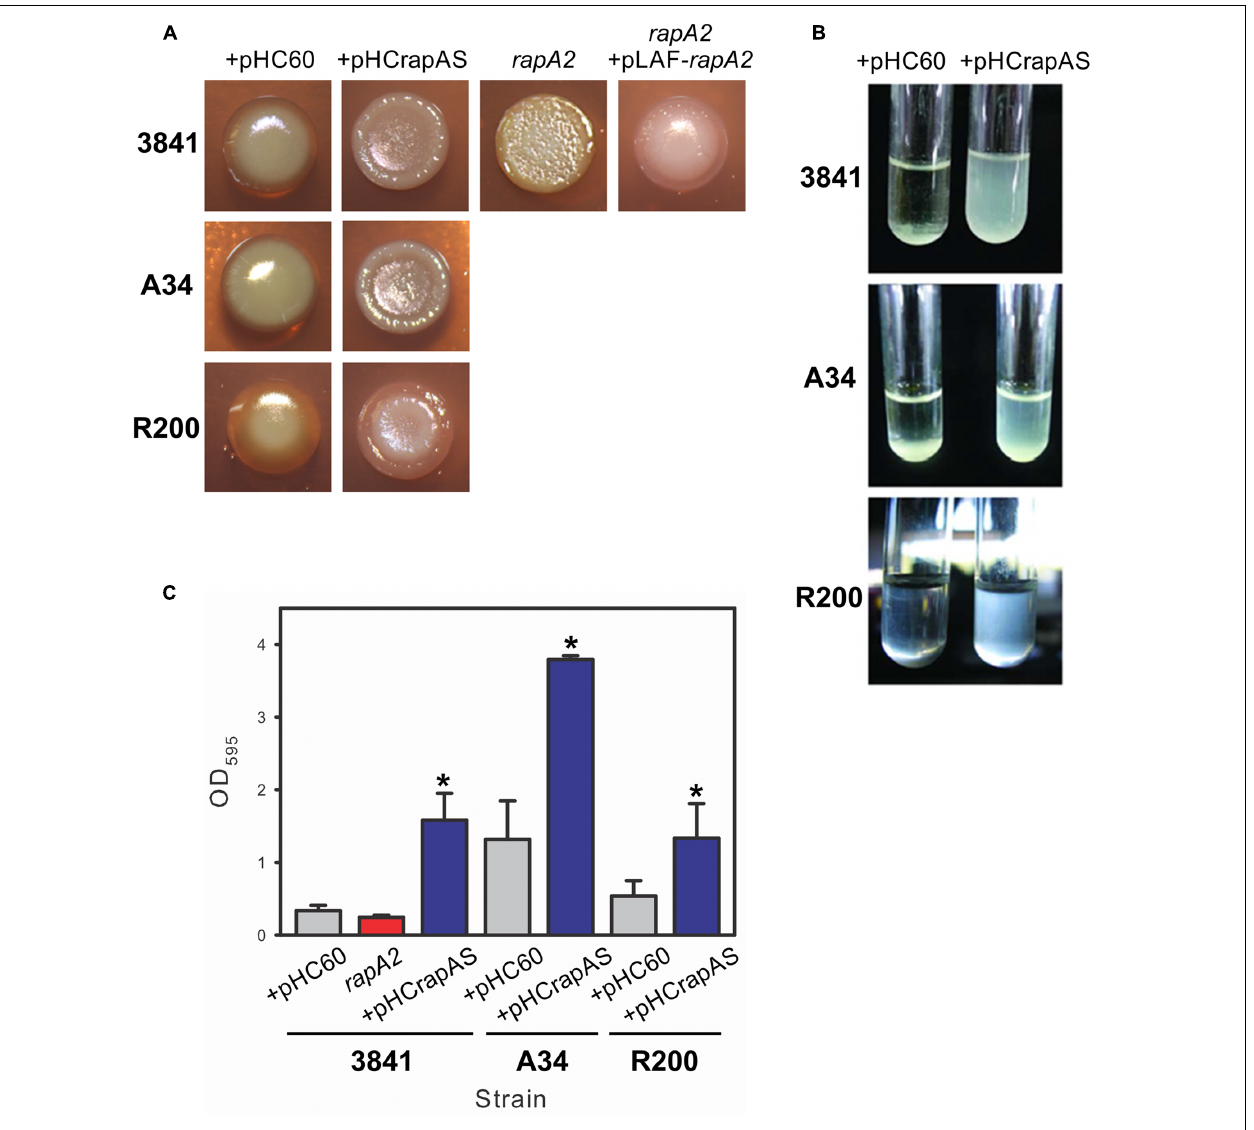
FIGURE 2 | Surface and biofilm phenotypes associated with RapA. (A) Standarized bacterial suspensions of Rhizobium leguminosarum 3841, A34, R200, and isogenic derivative strains were spotted on TY-Congo red agar plates and cultured for 4 days at 28 ◦ C. (B) Bacterial sedimentation in Y-minimal medium was observed using standardized cultures of R. leguminosarum strains harboring either pHC60 or pHCrapAS that were previously cultivated until late-exponential phase and then left standing during 10 h. (C) Adhesion to polystyrene of bacteria grown in Y-minimal medium. At least three independent experiments were conducted with six replicate wells per experiment; the error bars indicate one standard deviation. Statistical analysis was performed using one-way analysis of variance (ANOVA) followed by Turkey post hoc test (Sigma plot version 11.0, Systat Software Inc, USA). ∗ Significantly different from control ( P <